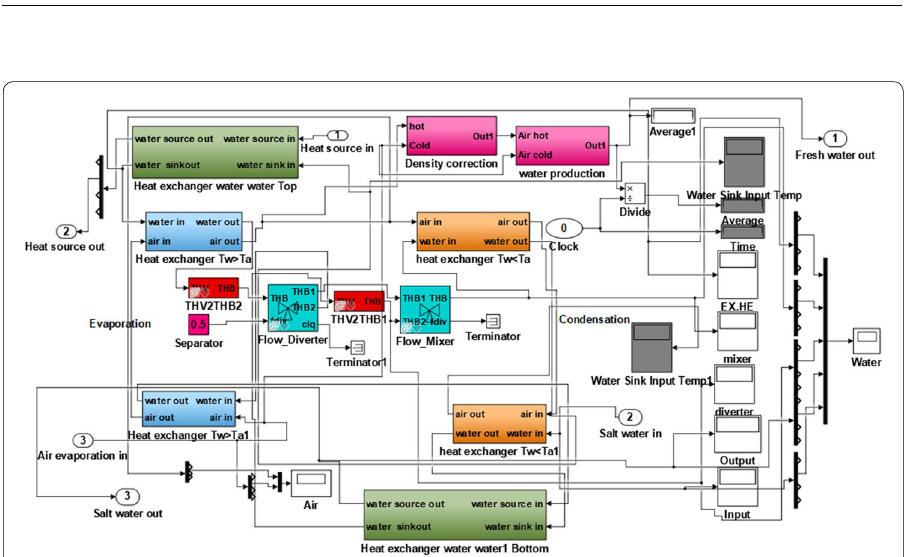
Fig. 3 Model representation of HDH unit in MATLAB